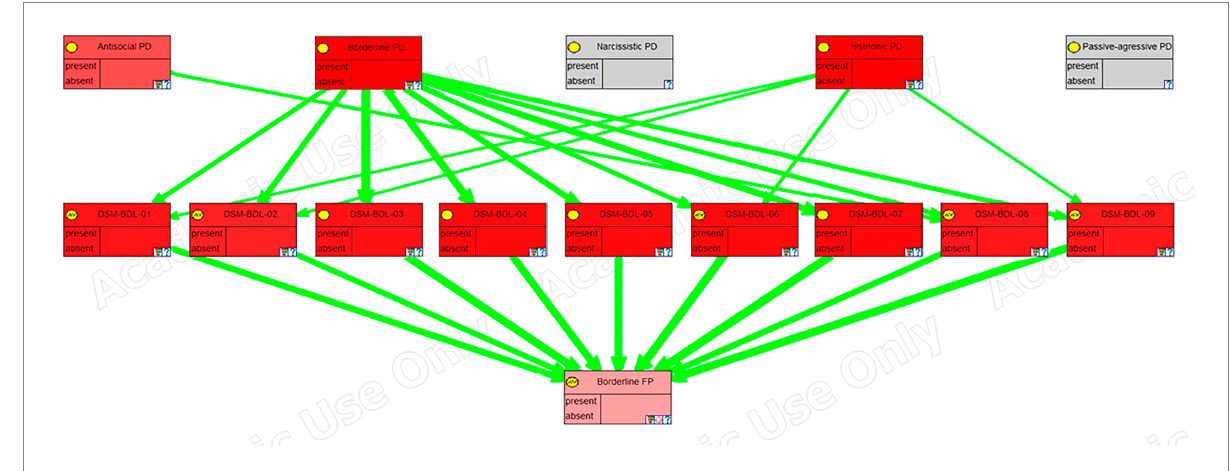
FIGURE 5 Sensitivity analysis, in GeNIE, for borderline DSM